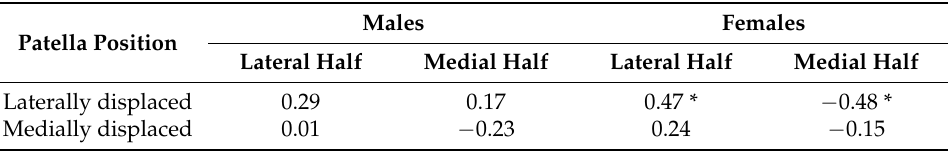
Table 2. Correlation coefficient between the q-angle and the changes in tendon shear modulus when the patella was laterally and medially displaced from its resting position. Males Females Patella Position Lateral Half Medial Half Lateral Half Medial Half Laterally displaced 0.29 0.17 0.47 * − 0.48 * Medially displaced 0.01 − 0.23 0.24 − 0.15